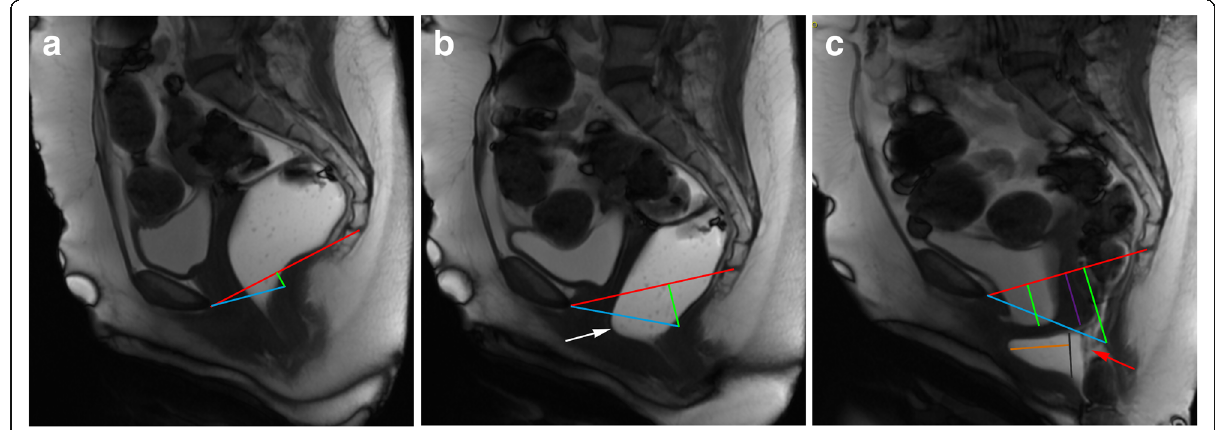
Fig. 9 Importance of the evacuation phase. ( a , b , c ) Sagittal midline TrueFISP images at rest ( a ), during straining ( b ), and evacuation ( c ) of a patient with descending perineal syndrome with tricompartimental prolapse, anterior rectocele, and rectal mucosa intussusception. Note that, although in the straining phase ( b ) the H and M lines (blue and right green lines) are already above the normal values, indicating a descending perineal syndrome, and a mild bulge of the anterior rectal wall is seen (white arrow), only in the evacuation phase ( c ) the true pelvic floor disorder is adequately characterized, with a tricompartimental prolapse (cystocele, uterine prolapse, and rectal prolapse) the true size of the rectocele is documented (orange line: 4.8 cm) and the rectal mucosa intussusception is depicted (red arrow). Left green line : extent of cystocele; purple line : extent of uterine prolapse; black line : normal expected contour of the anterior anorectal wall; red line : PCL line